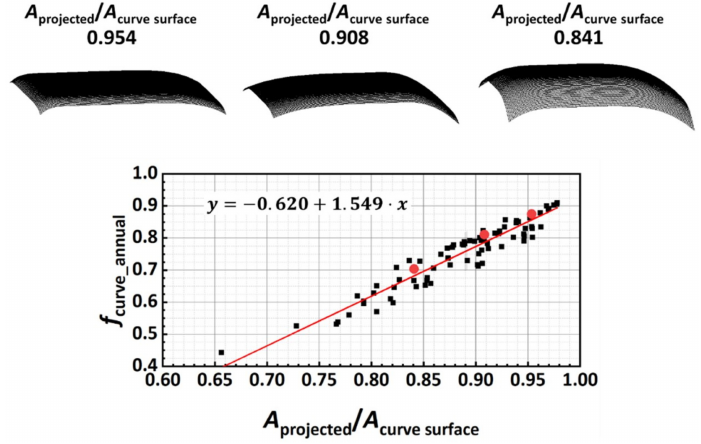
Figure 5. f curve_annual as a function of A propjected / A curved surface . Curve shapes corresponding to A projected / A curve-surface = 0.841, 0.908, and 0.954 are also shown, respectively, and are plotted as solid red circles in the graph.